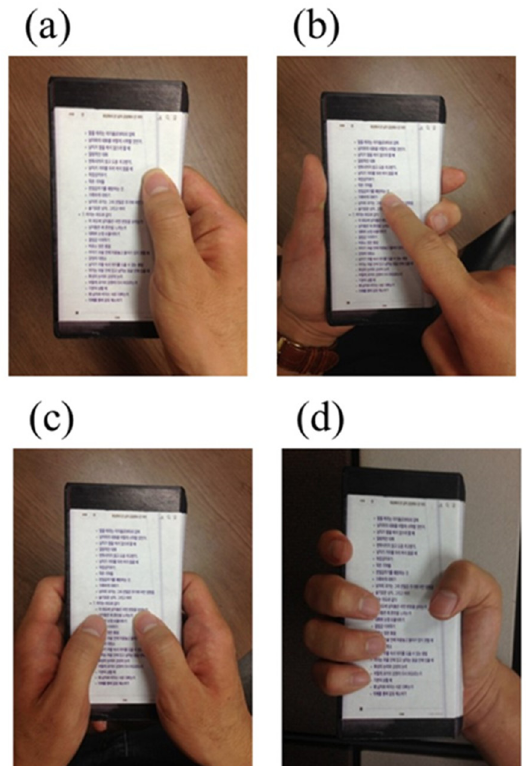
Figure 2. Illustration example of the four main usage patterns when using a smartphone. ( a ) Manipulate with the right thumb finger while gripping with the right hand. ( b ) Manipulate with the right index finger while gripping with the left hand. ( c ) Manipulate with both thumb while holding in both hands. ( d ) Manipulate with the right thumb finger while power grip.